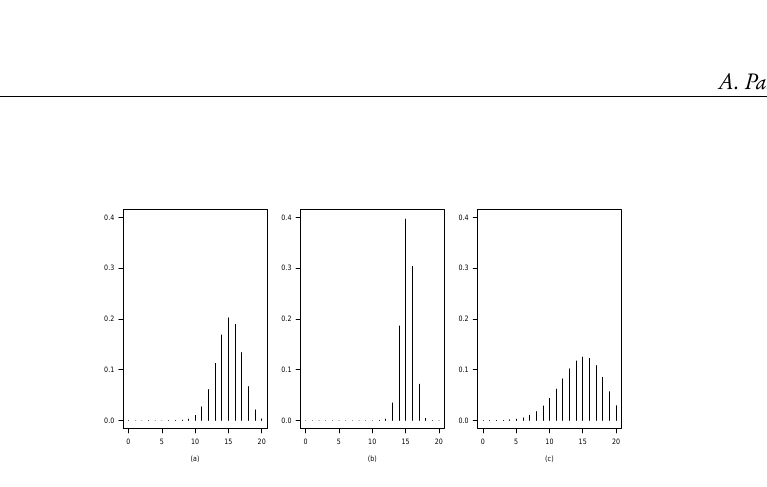
Figure 11 – An original binomial distribution { p and intermediate binomial distributions { q (b), and for m = 20, θ = 0.75, and α = 0.35, in panel (c).